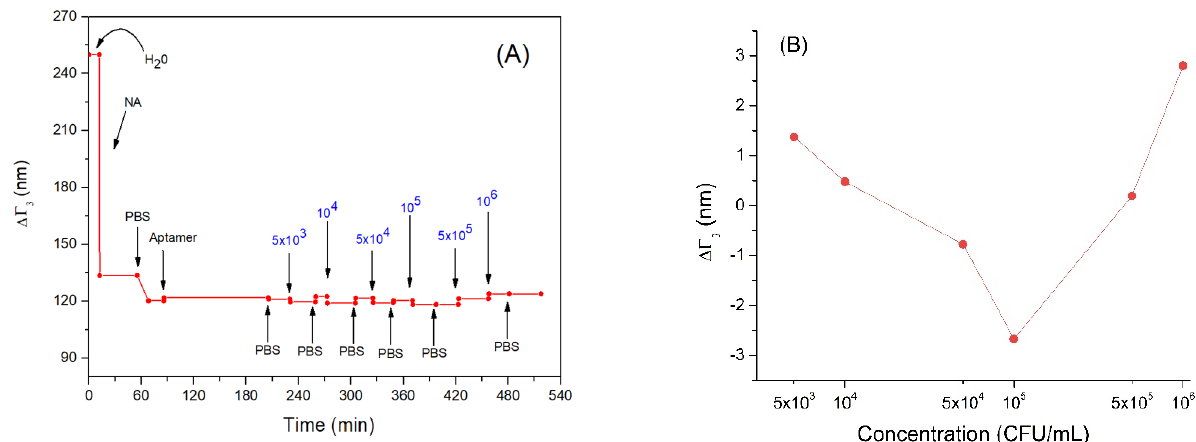
Figure 5. ( A ) the kinetics of the changes of penetration depth during formation of the aptamer layer and addition of Listeria innocua (in CFU/mL). ( B ) Changes in penetration depth depending on applied bacteria concentration in logarithmic scale. Addition of various compounds and washing the surface by water or PBS is shown by arrows.